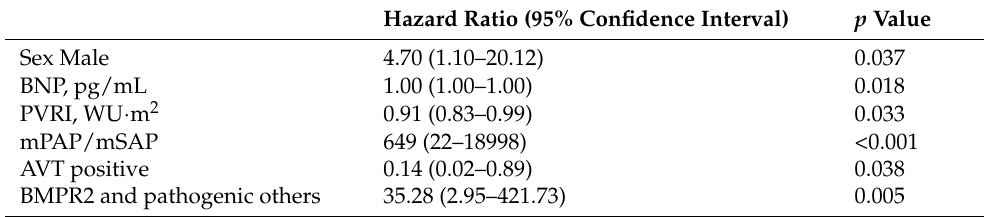
Table 3. Multivariate Cox regression model for IPAH/HPAH risk of mortality final